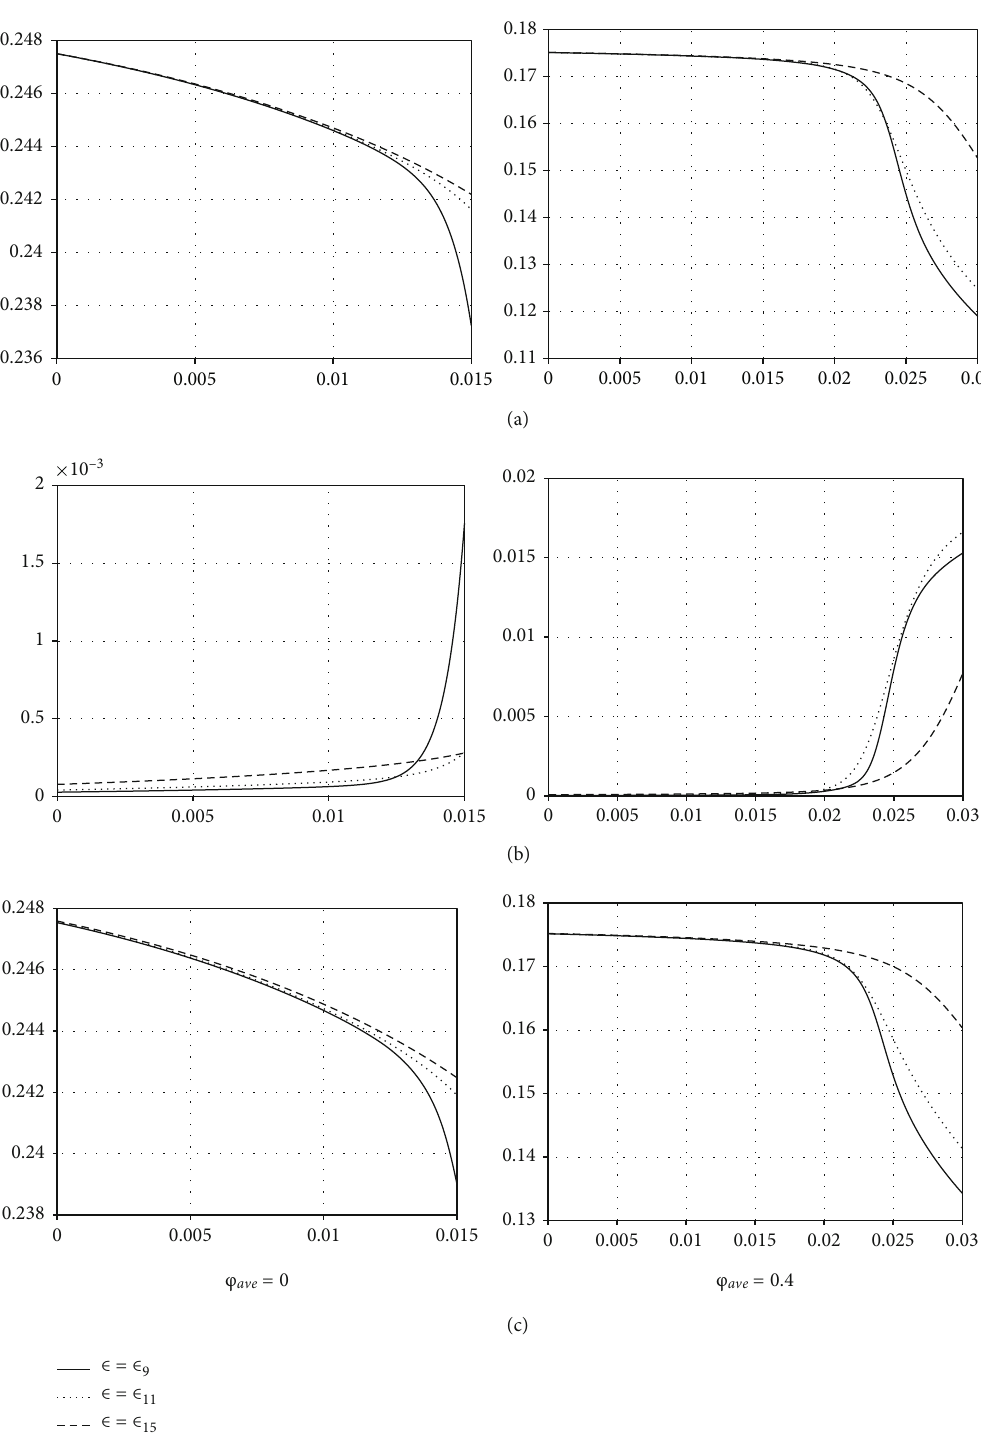
ð ϕ Þ , and (c) E ð ϕ Þ for each ε : ε 2